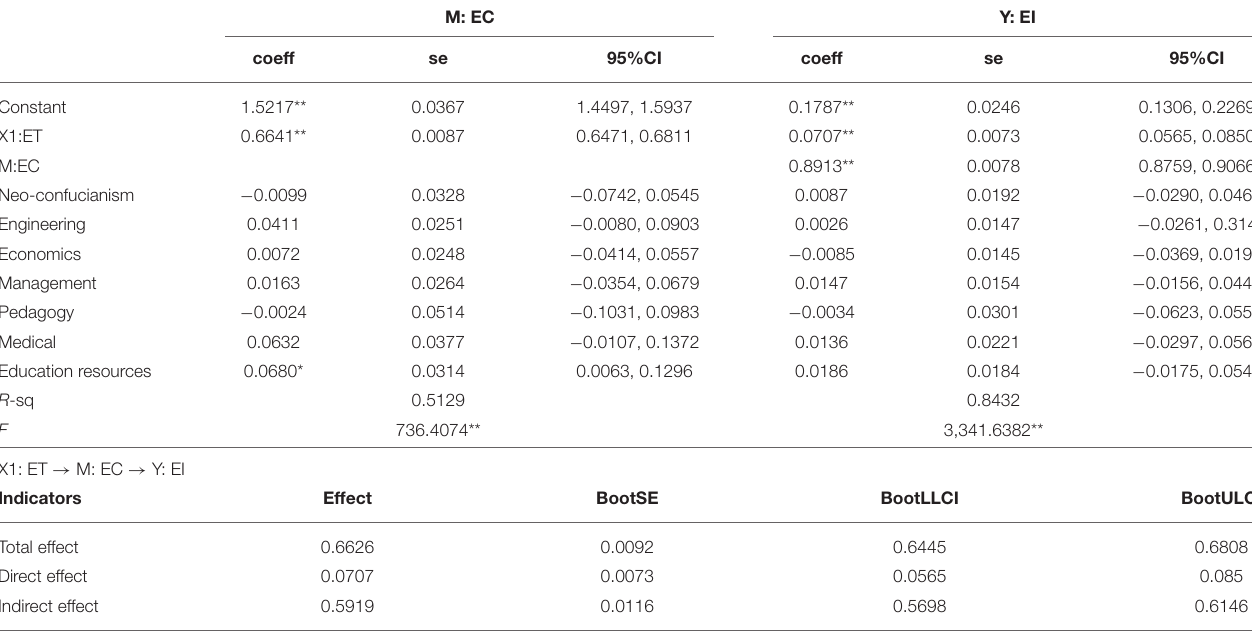
TABLE 4 | The mediating effect of ET as independent variable was analyzed.